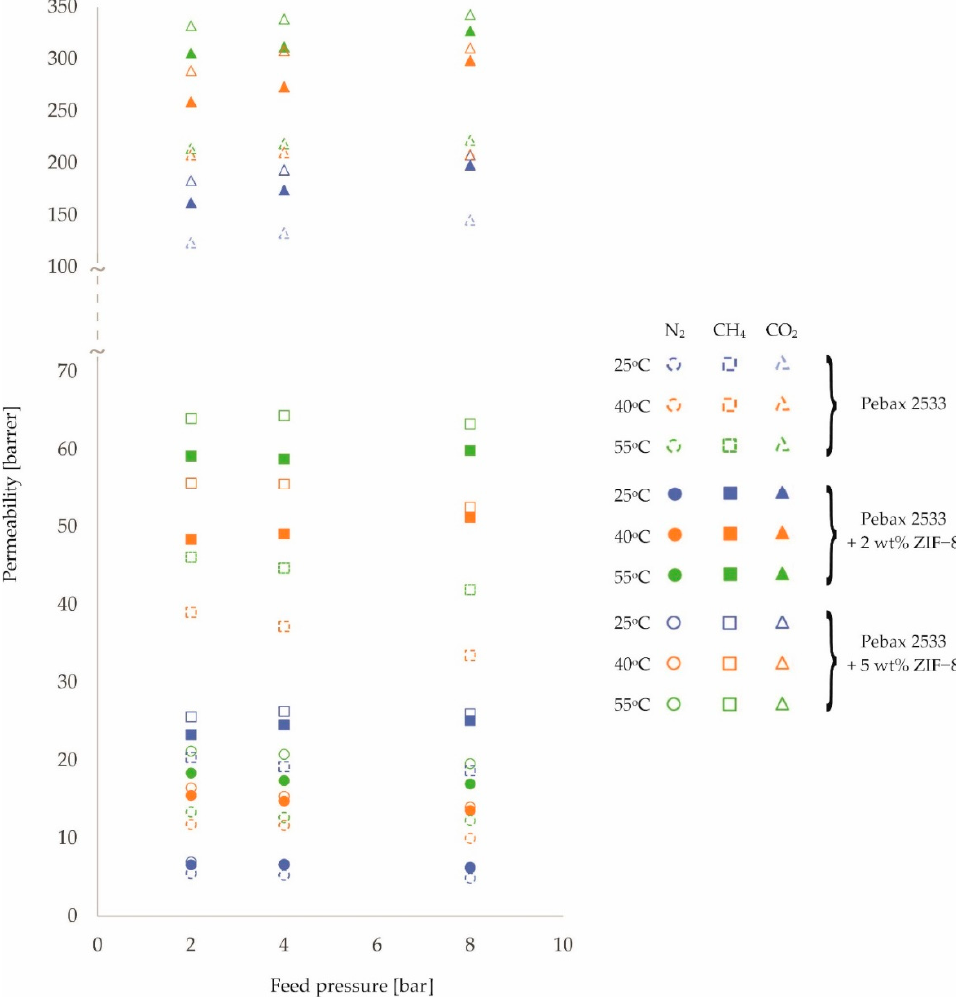
Figure 2. Change in permeability values of homogeneous membrane and heterogeneous membranes containing ZIF − 8 for different feed pressure and temperature values.